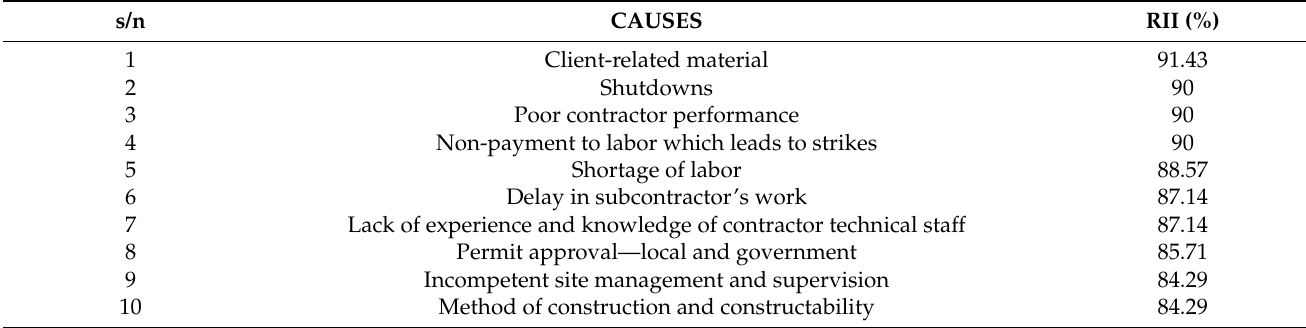
Table 6. Top ten causes from owner point of